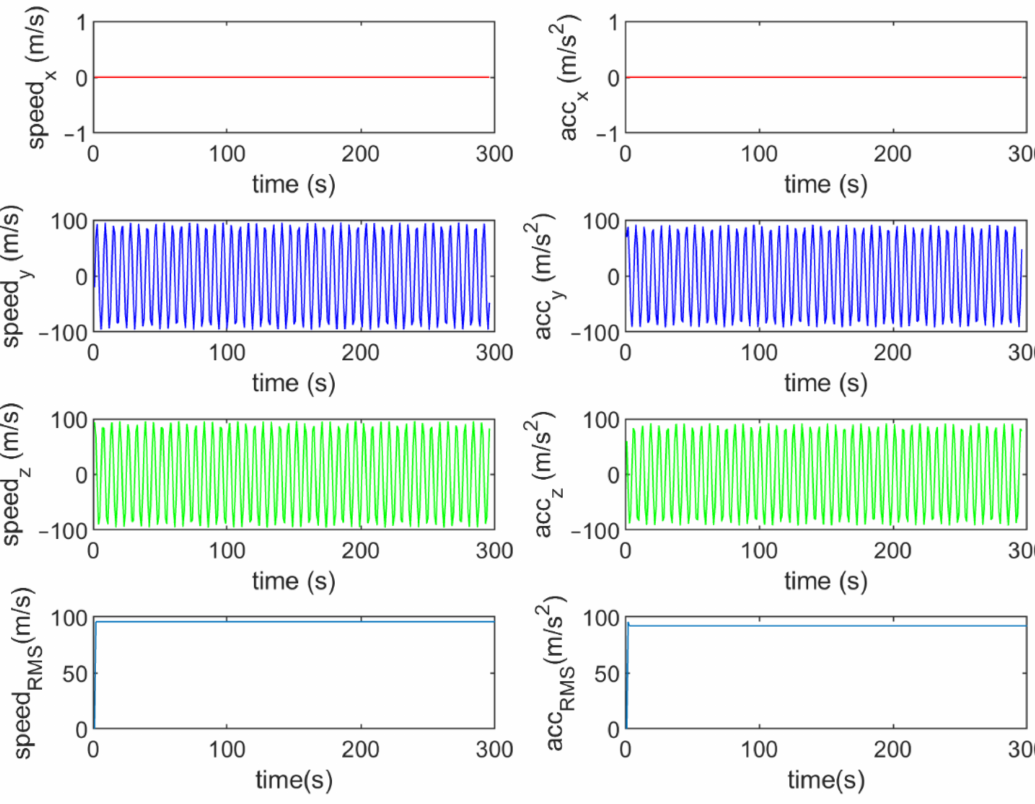
Figure 11. The speed and acceleration components in the second